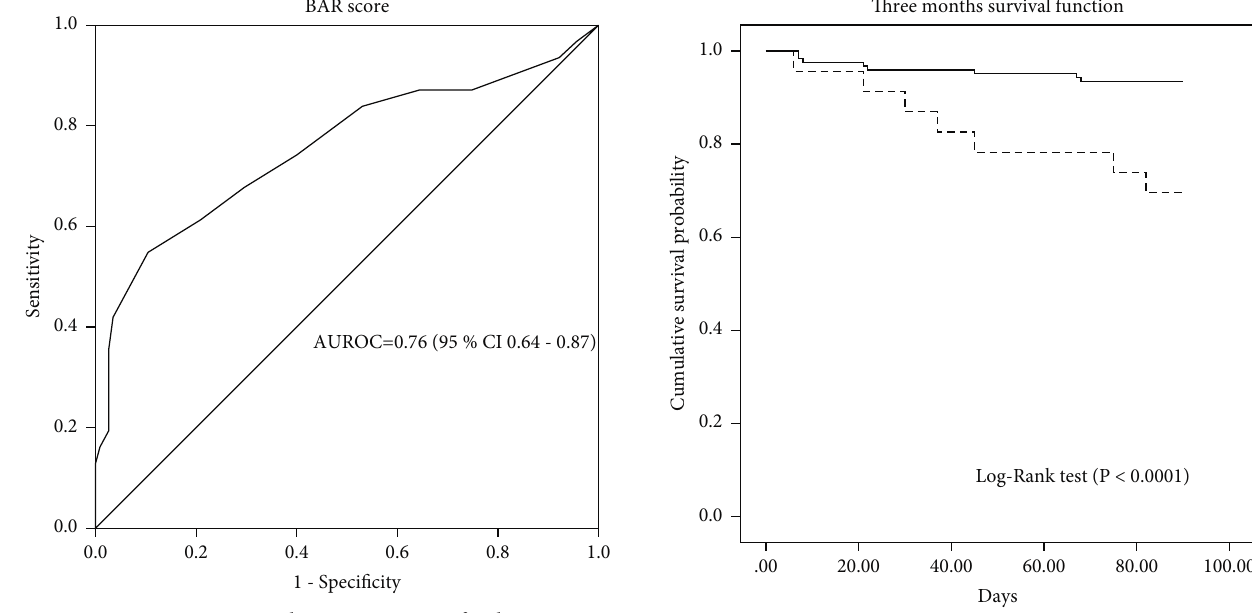
Figure 2: Receiver operating characteristic curve for the BAR score in predicting post-transplant 1-year survival. BAR, balance of risk; AUROC, area under the receiver operating characteristic curve.